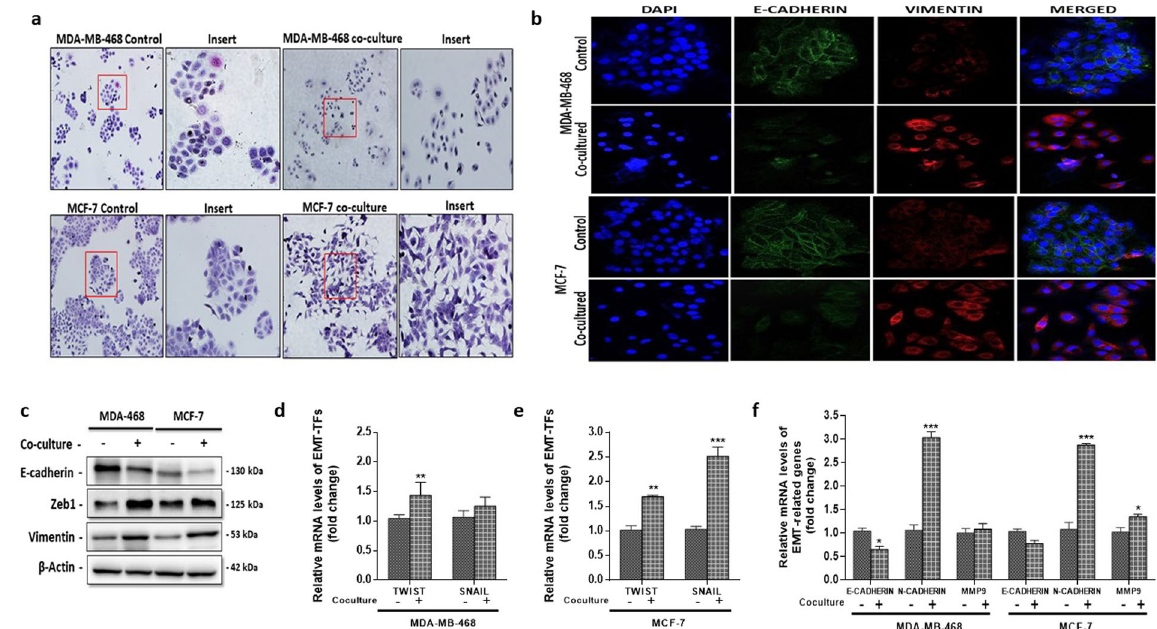
Figure 3. Human adipocytes induced EMT-phenotype with alteration in EMT-related gene expression. ( a ) Morphological characteristics of MDA-MB-468 and MCF-7 cells compared with cells co-cultured with human adipocytes. Co-cultured breast cancer cells were dispersed and slightly elongated. ( b ) Immunofluorescence staining of e-cadherin and vimentin. ( c ) Western blot for e-cadherin, vimentin and ZEB1 in MDA-MB-468 and MCF-7 breast cancer cells cultured with or without adipocytes. Full-length blots are presented in Supplementary Fig. 5. ( d,e ) Quantitative PCR (qt-PCR) comparing the expression of EMT-TFs (TWIST and SNAIL) in co-cultured breast cancer cells to control cells. ( f ) qt-PCR comparing the expression of EMT-related genes (MMP9, N-cadherin and E-cadherin) in co-cultured breast cancer cells to control cells. Relative mRNA expression was normalized to GADPH. All results are representative of 3 independent experiments. (Data indicate mean ± SEM; *** p < 0,001; ** p < 0.01; * p <